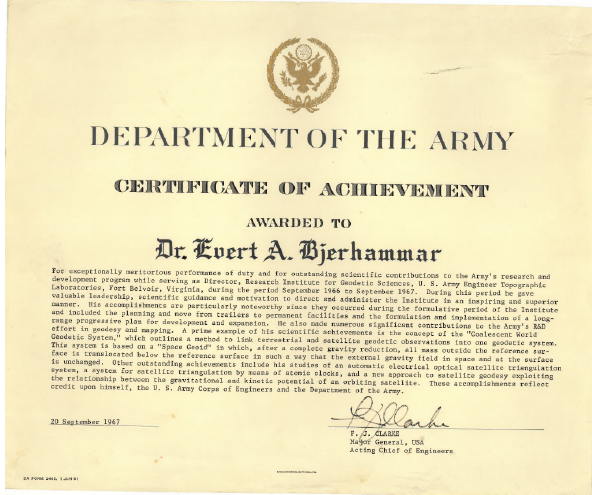
Fig. 2. The Certificate of Achievement awarded by the US Army in